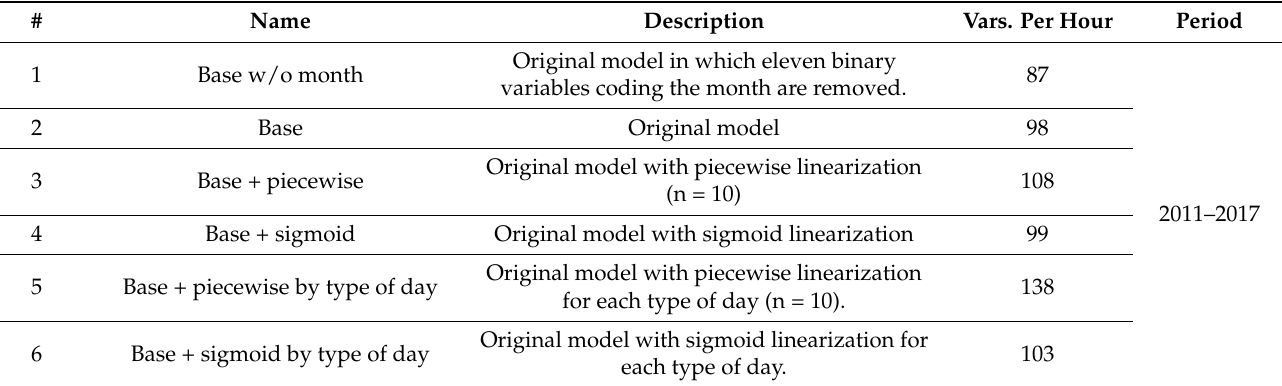
Table 4. Description of the models tested in the design phase.